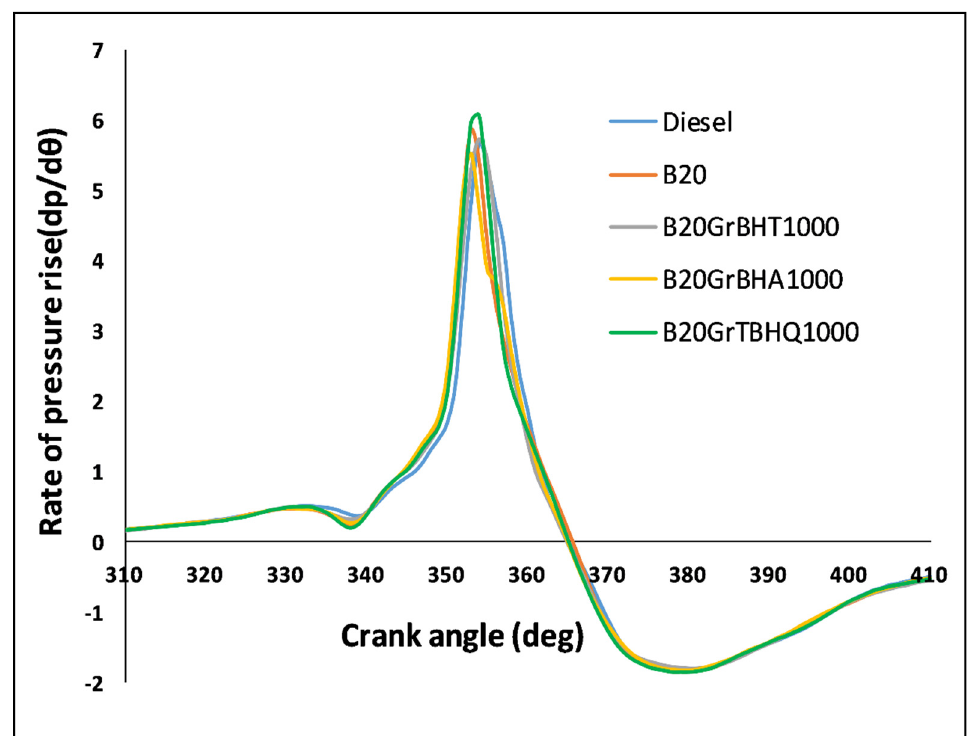
Figure 7. Deviation of pressure rise rate with crank angle.